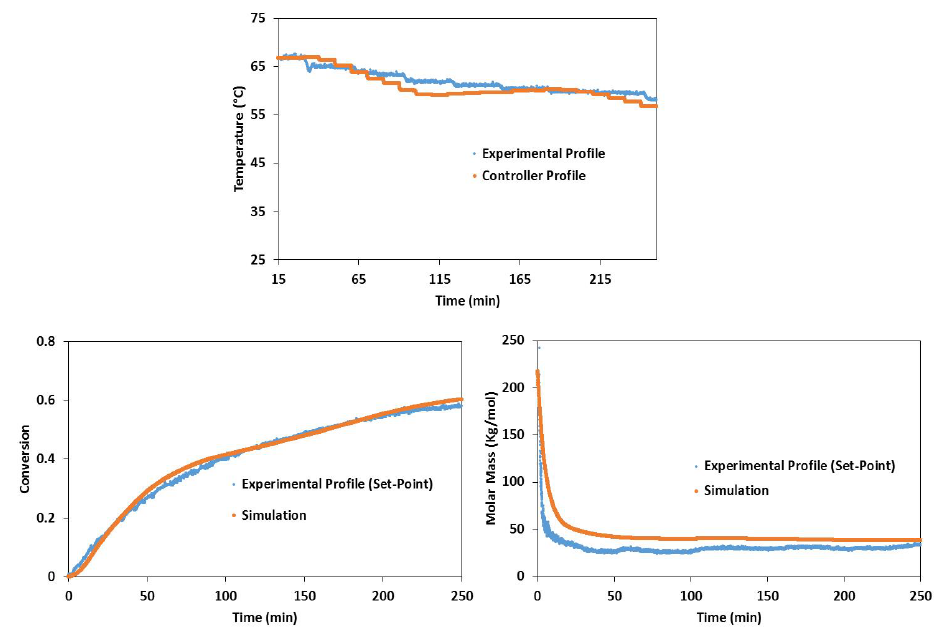
Figure 14. Closed-loop results using single loop controller.